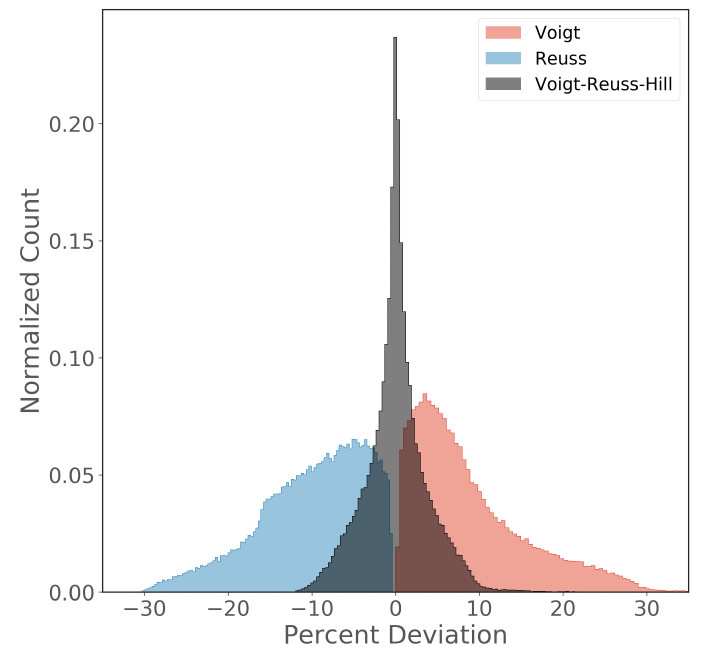
Figure 3. Distribution of the deviation of the Debye speed obtained using acoustic wave speeds estimated using the Voigt (red), Reuss (blue), and Voigt-Reuss-Hill (grey) averaged elasic moduli with respect to the true Debye speed. One million randomly generated tensors of materials with hexagonal symmetry and identical seismic wave speeds are